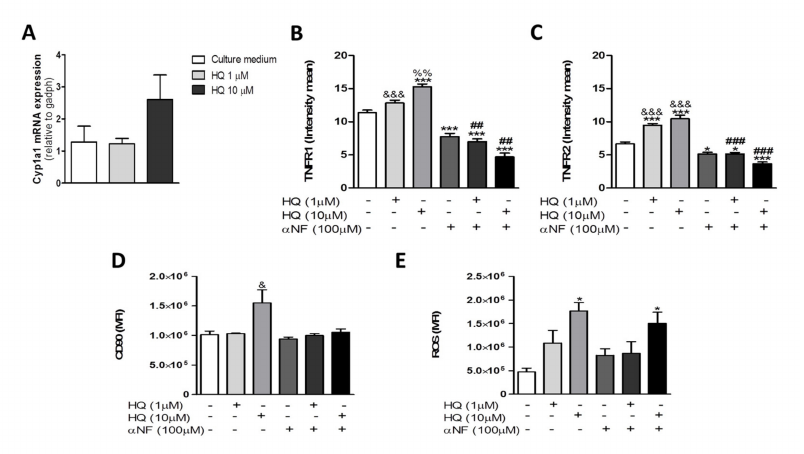
Figure 5. In vitro AhR antagonist treatment prevents cell proliferation and TNFRs expression evoked by HQ exposure. RAHFLS (1 × 10 4 cells) were treated with HQ (1 or 10 µ M) with or without the AhR antagonist α -naphthoflavone ( α NF, 100 µ M). After 30 min of treatments, the Cyp1a1 mRNA expression was quantified by RT-PCR ( A ). After 24 h of treatments, the TNRF1 and TNFR2 expression were quantified by indirect immunofluorescence assay in the synovial cells ( B , C ) and the synovial proliferation was quantified through flow cytometry ( D ). The ROS generation was quantified using DCFH-DA assay ( E ). Data represent mean ± SEM of three independent experiments in RAHFLS. Data were analyzed by one-way ANOVA. * p < 0.05 and *** p < 0.001 vs. culture medium; & p < 0.05 and &&& p < 0.001 vs. α NF; %% p < 0.01 vs. HQ 1 µ M; @@ p < 0.01 vs. HQ 10 µ M + α NF; ## p < 0.01 and ### p < 0.001 vs. respective groups without α